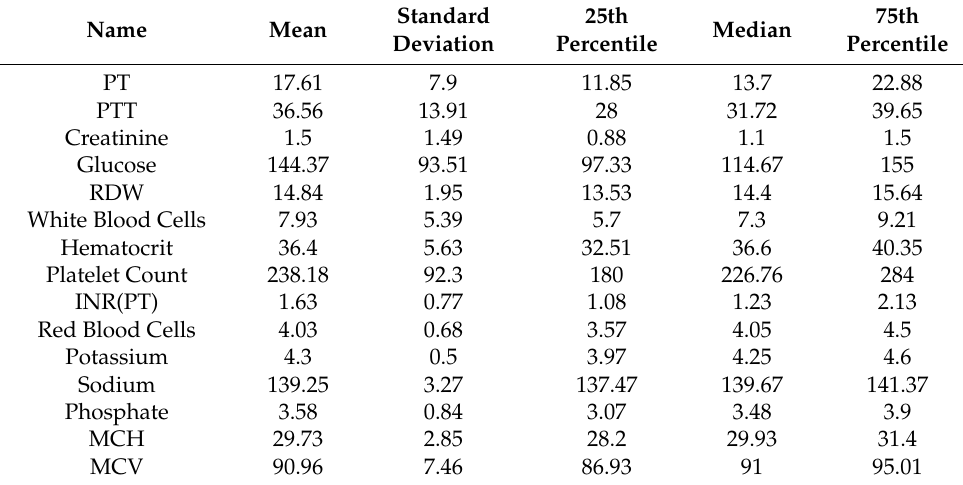
Table 1. Covariate